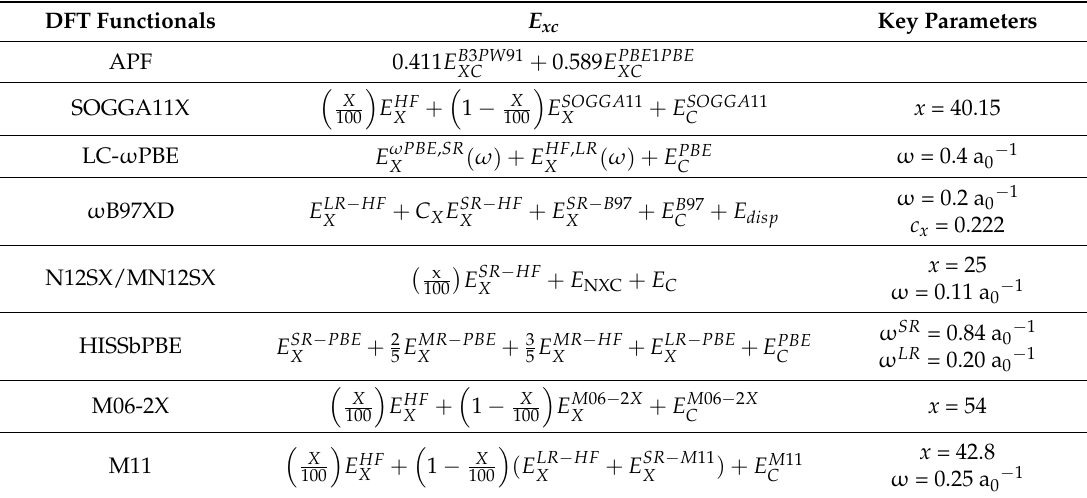
Table 1. The exchange-correlation energy of the selected density functional theory (DFT) functionals in this work.